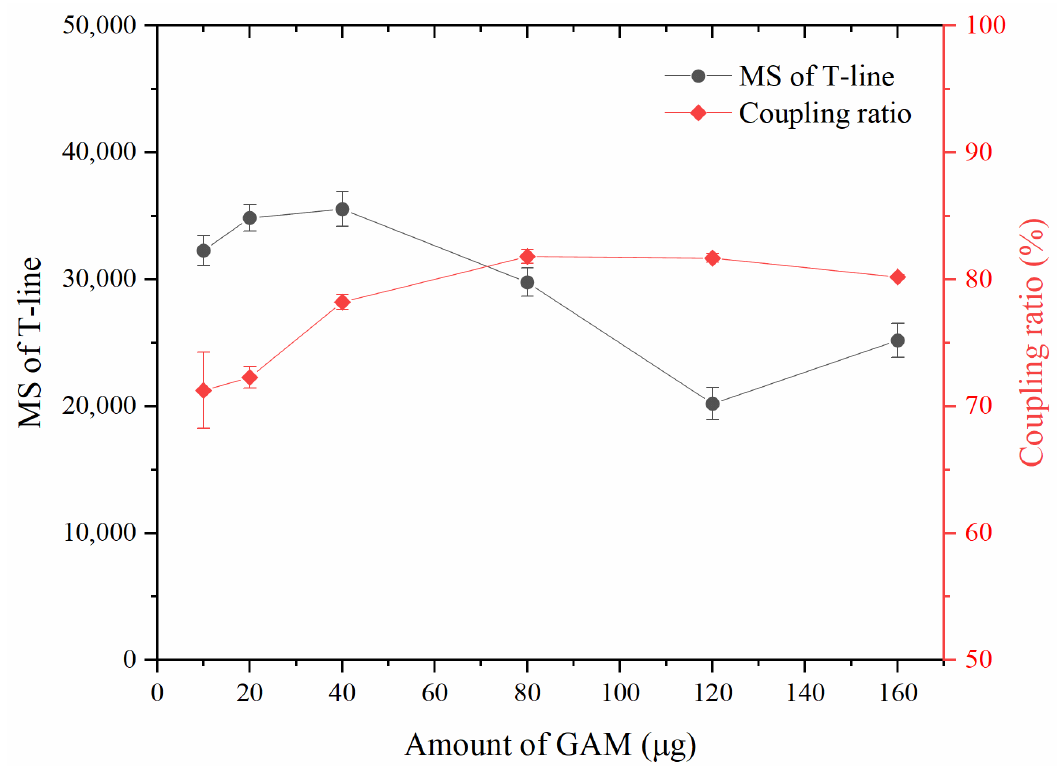
Figure 4. Optimization of the secondary antibody amount coupled onto the surface of MNPs. The error bars represent the standard deviation of three repeats (n = 3).